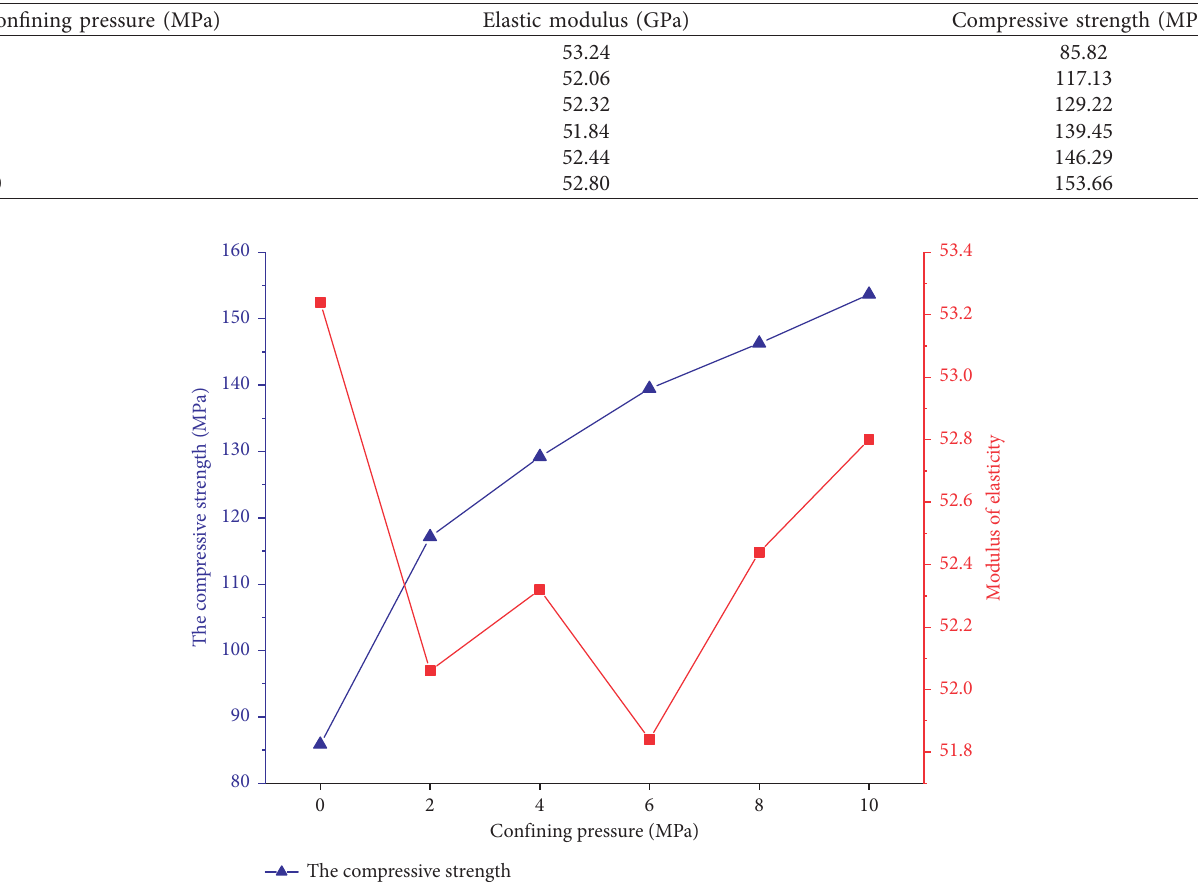
Table 2: Statistics of numerical calculation results of elastic modulus and compressive strength of shale.